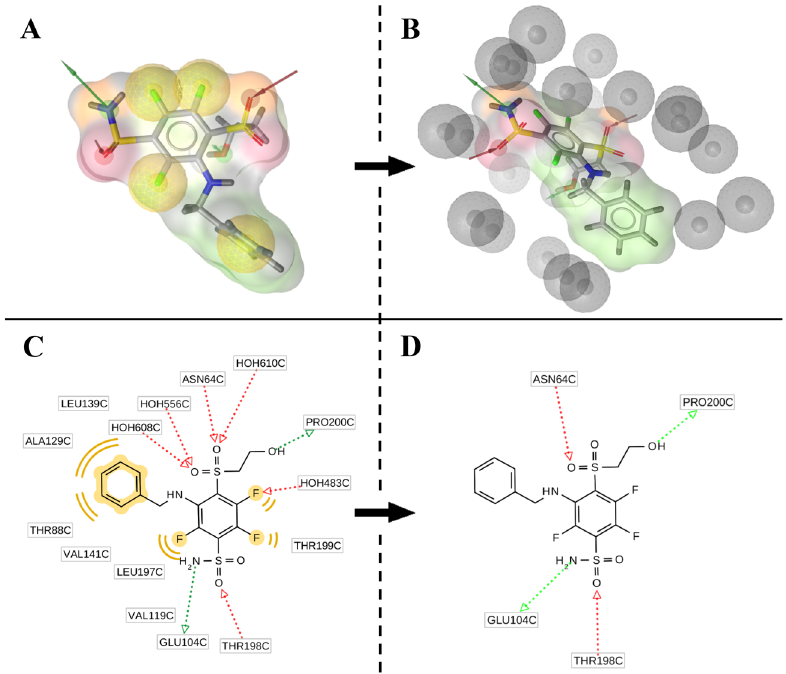
Figure 3. The best generated structure-based pharmacophore model. 3D ( A ) and 2D ( C ) representations of the pharmacophore model with all initial features. Final pharmacophore models after removing features responsible for the interactions with water molecules and hydrophobic interactions ( B , D ) and addition of the exclusion volumes coat ( B ). Figures of structure-based pharmacophore model was obtained using LigandScout v4.4 27 (www. intel igand. com/ ligan dscout/). Schematic illustration was drawn using Adobe Illustrator 2018 (www. adobe. com/ produ cts/ illus trator).